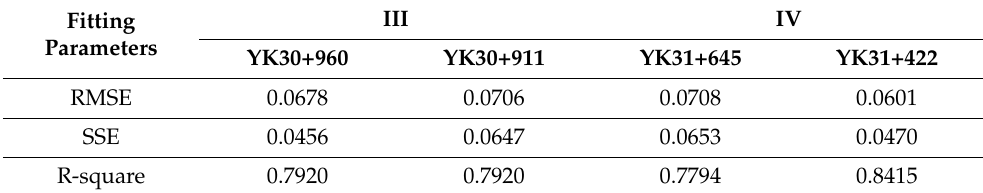
Table 2. Fitting parameters of surrounding rock.